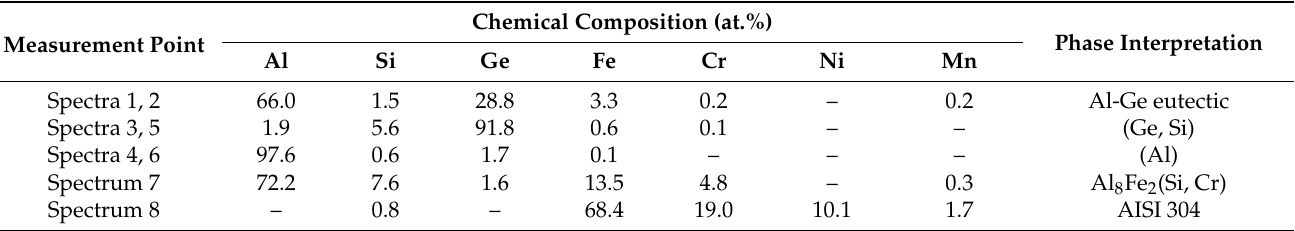
Table 3. Results of EDX analysis of the AISI 304/Al-40.0Ge-3.4Si wt.% filler according to 540 ◦ C/10 min mode alloy wetting experiment.